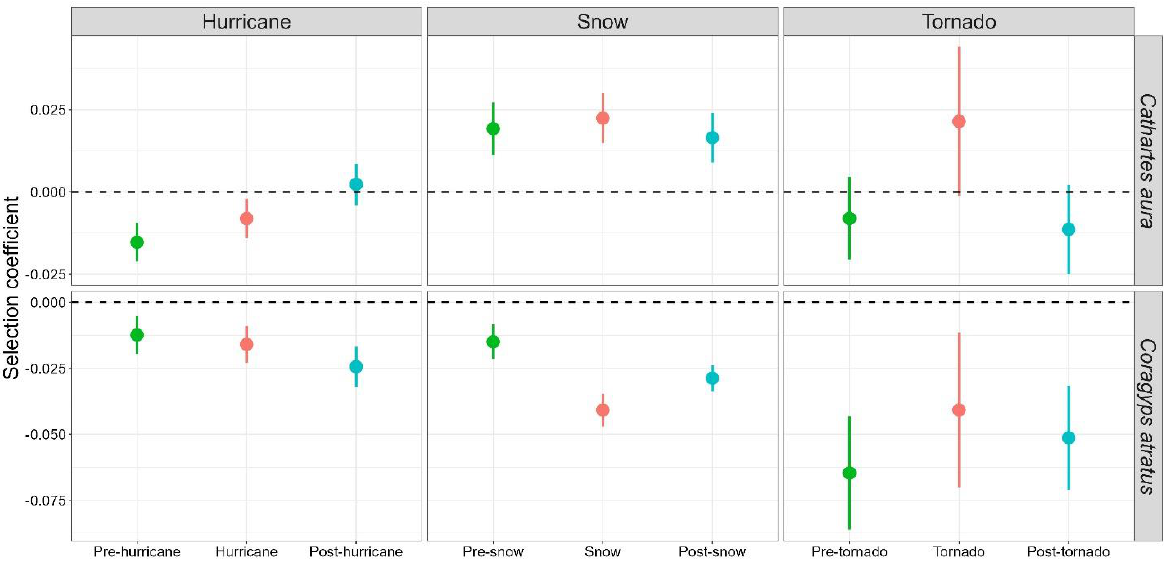
Figure 5. Selection strength of forest cover for black and turkey vultures ( Coragyps atratus and Cathartes aura , respectively) before (green), during (pink), and after (blue) extreme weather events in Mississippi.